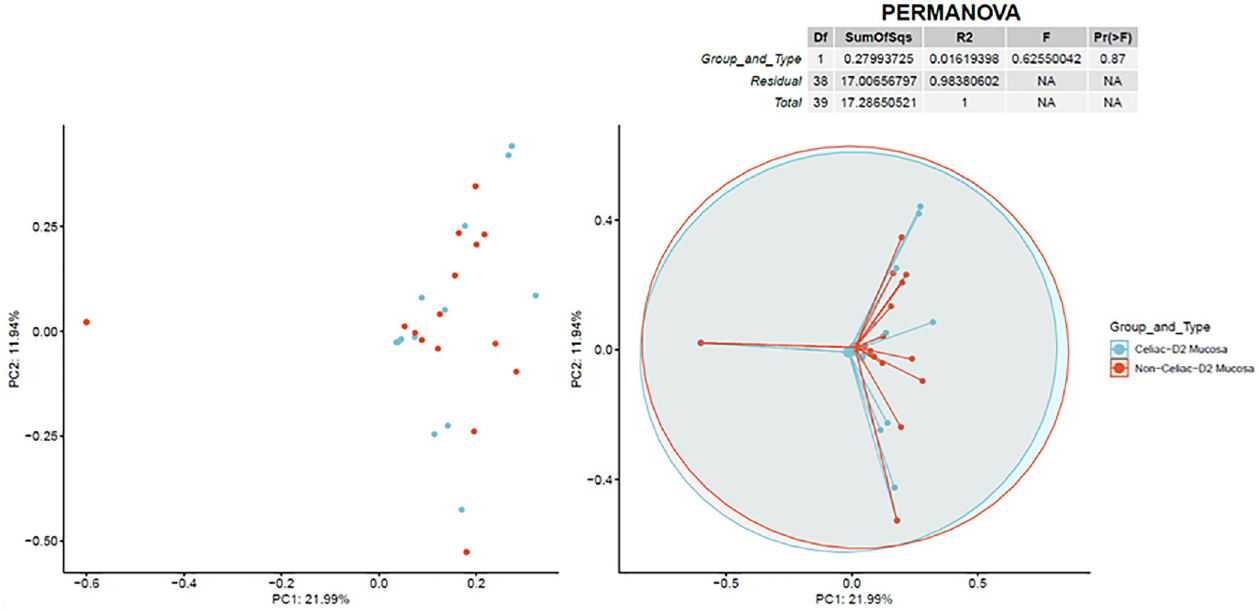
Fig 3. Bray-Curtis beta diversity in mucosa. Two-dimensional principal coordinate analysis for viral species in mucosal samples showing almost complete overlap of CeD samples celiac (CeD) and non-CeD samples. The right plot overlays a 95% confidence ellipse over each cohort and lines connect all values to the average of the cohort.